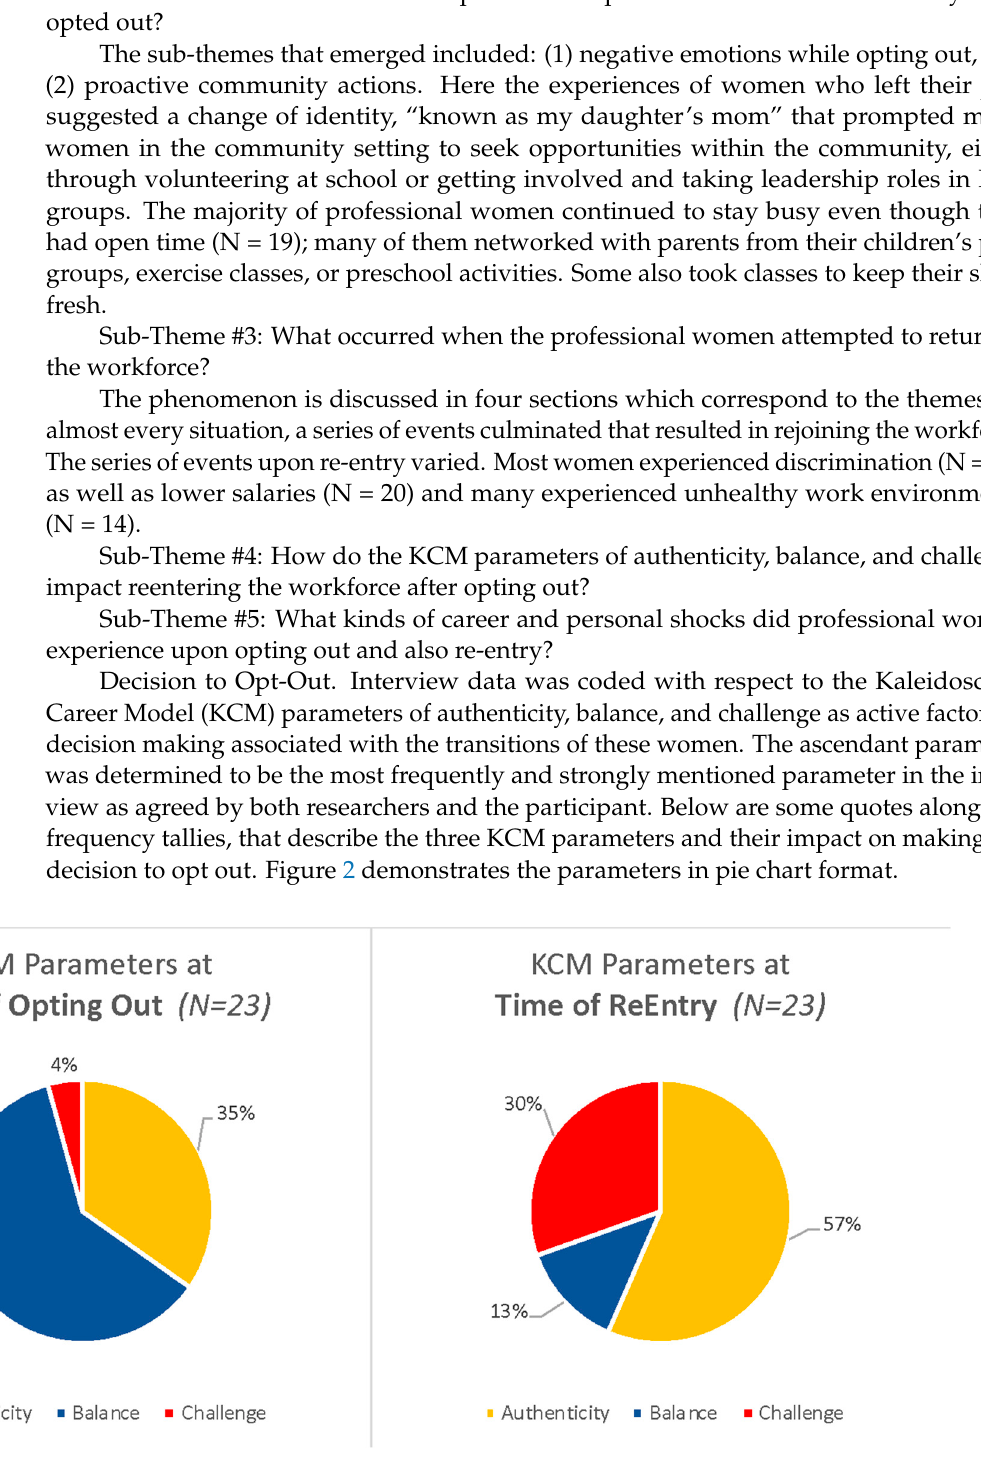
Figure 2. Ascendant KCM parameters from coded interview data at Time 1 (opting out) versus Time 2 (re-entry).